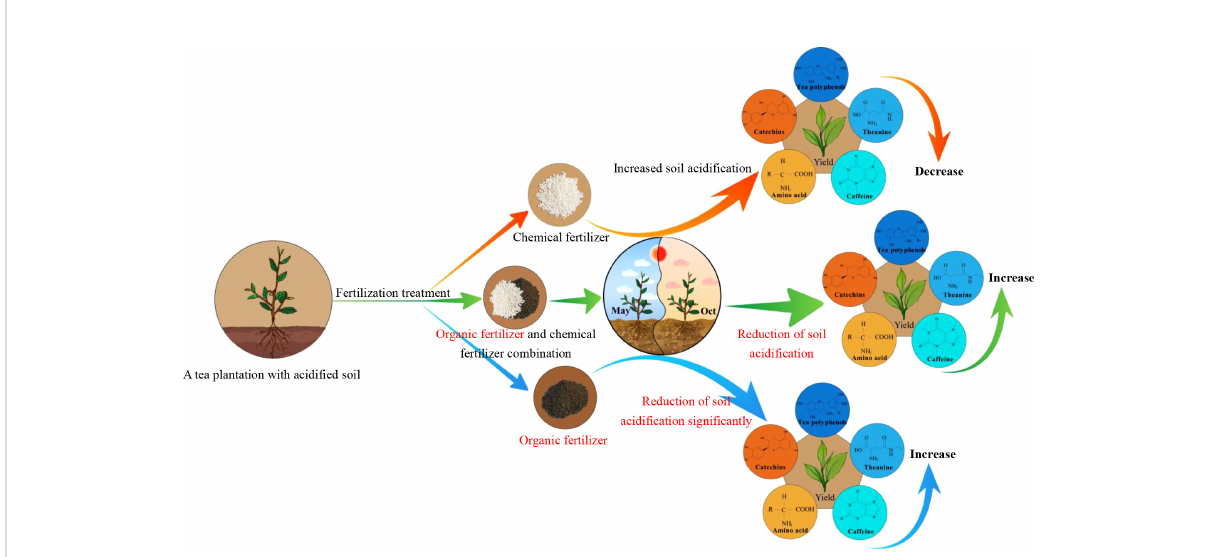
FIGURE 7 Effects of different fertilizer treatments on soil pH, tea yield (spring tea in May, autumn tea in October) and quality in tea plantation. Chemical fertilizer can aggravate soil pH and reduce tea yield and quality. Organic fertilizer combined with chemical fertilizer can alleviate soil acidi fi cation and improve the yield and quality of tea. Organic fertilizer treatment can effectively improve soil acidi fi cation in tea plantations and signi fi cantly improve tea yield and